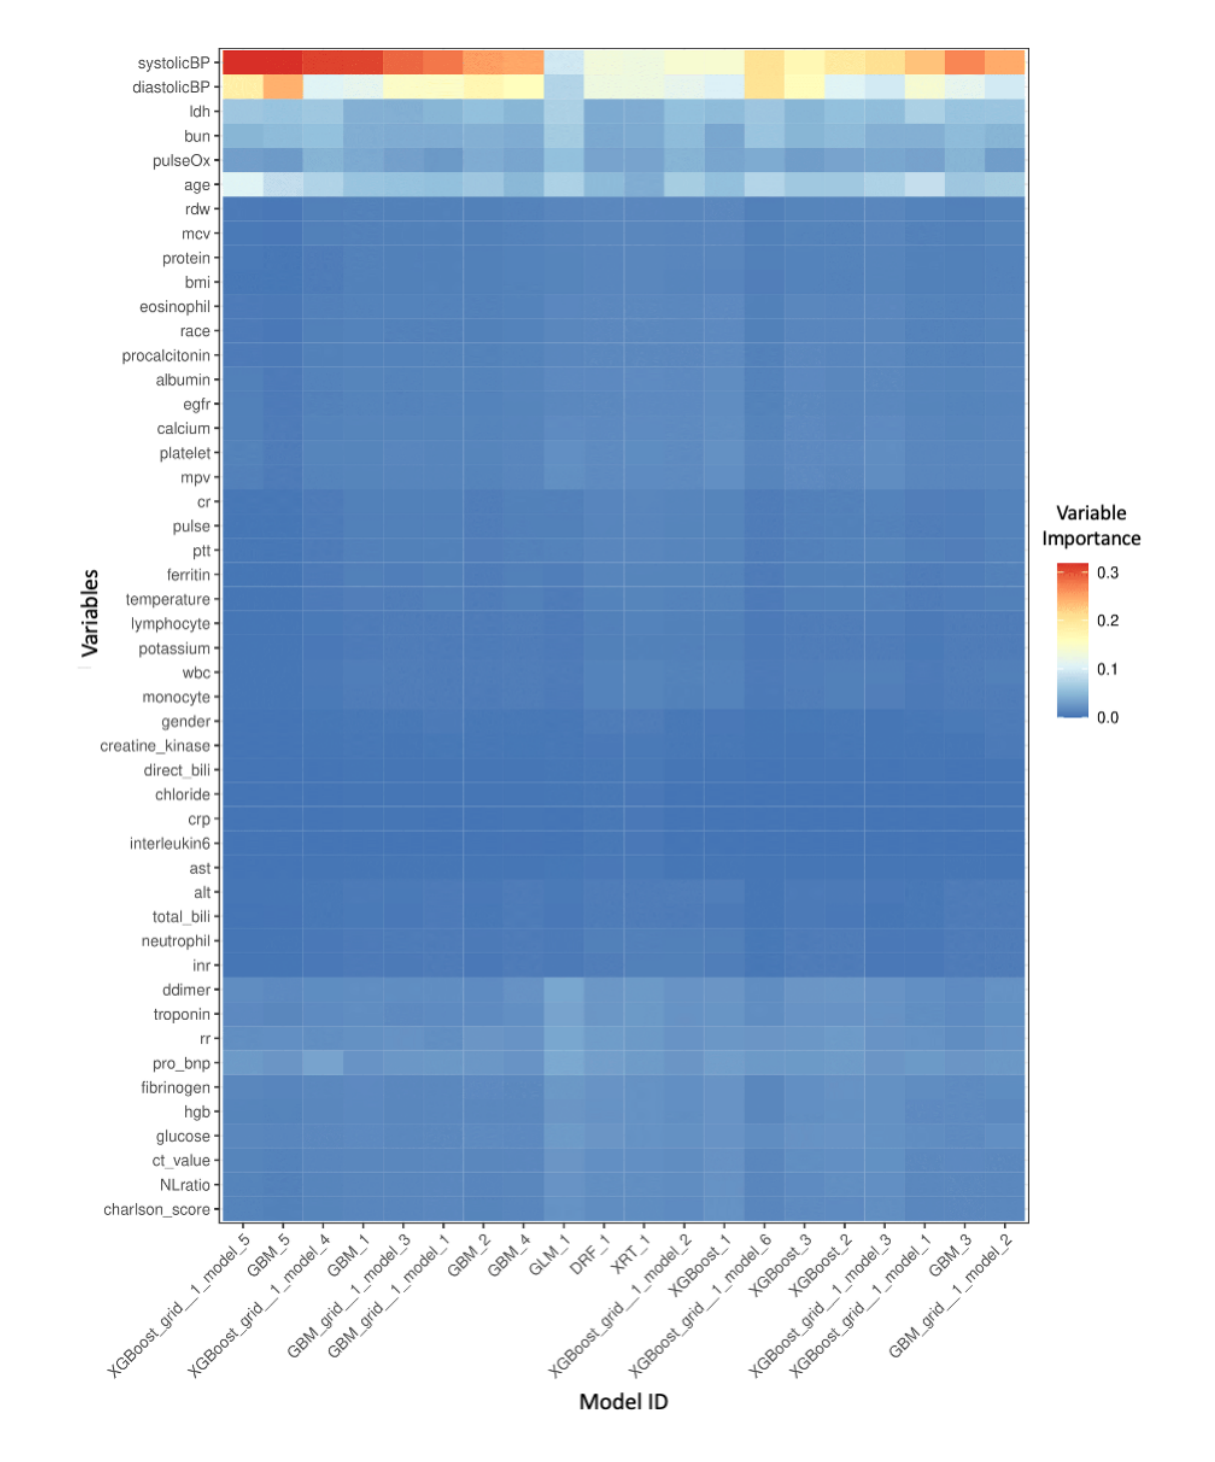
Figure 5. A heatmap that represents the importance of each variable in every machine learning model. DRF: distributed random forest; GBM: gradient